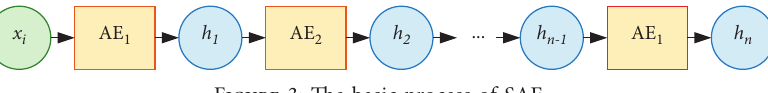
Figure 3: The basic process of